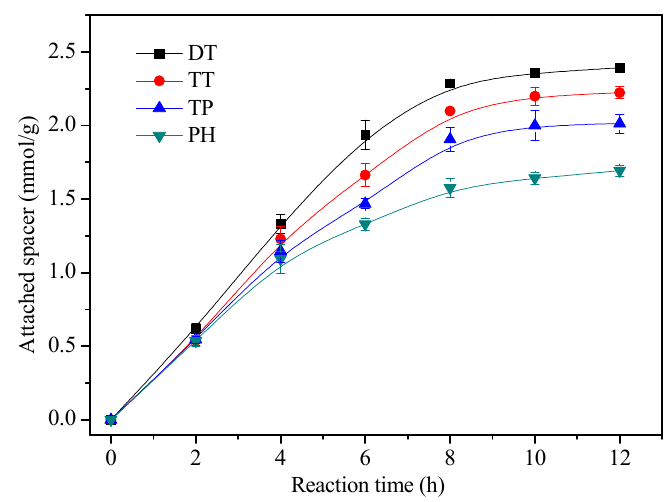
Figure 4. Effect of the reaction time on the amount of attached spacer on the oxidized BC, T = 30 ◦ C (40 ◦ C for PH), initial spacer concentration = 8% ( v / v ).